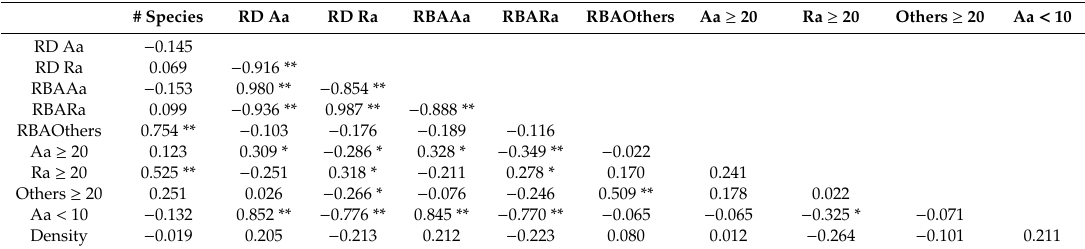
Table 3. Spearman’s correlation coe ffi cients for the di ff erent variables attributed to grouping of plots in accretion and erosion sites. Variables represent number of species (# species), relative density (RD), and relative basal area (RBA) of tree species, number of trees ≥ 20 cm DBH ( ≥ 20), number